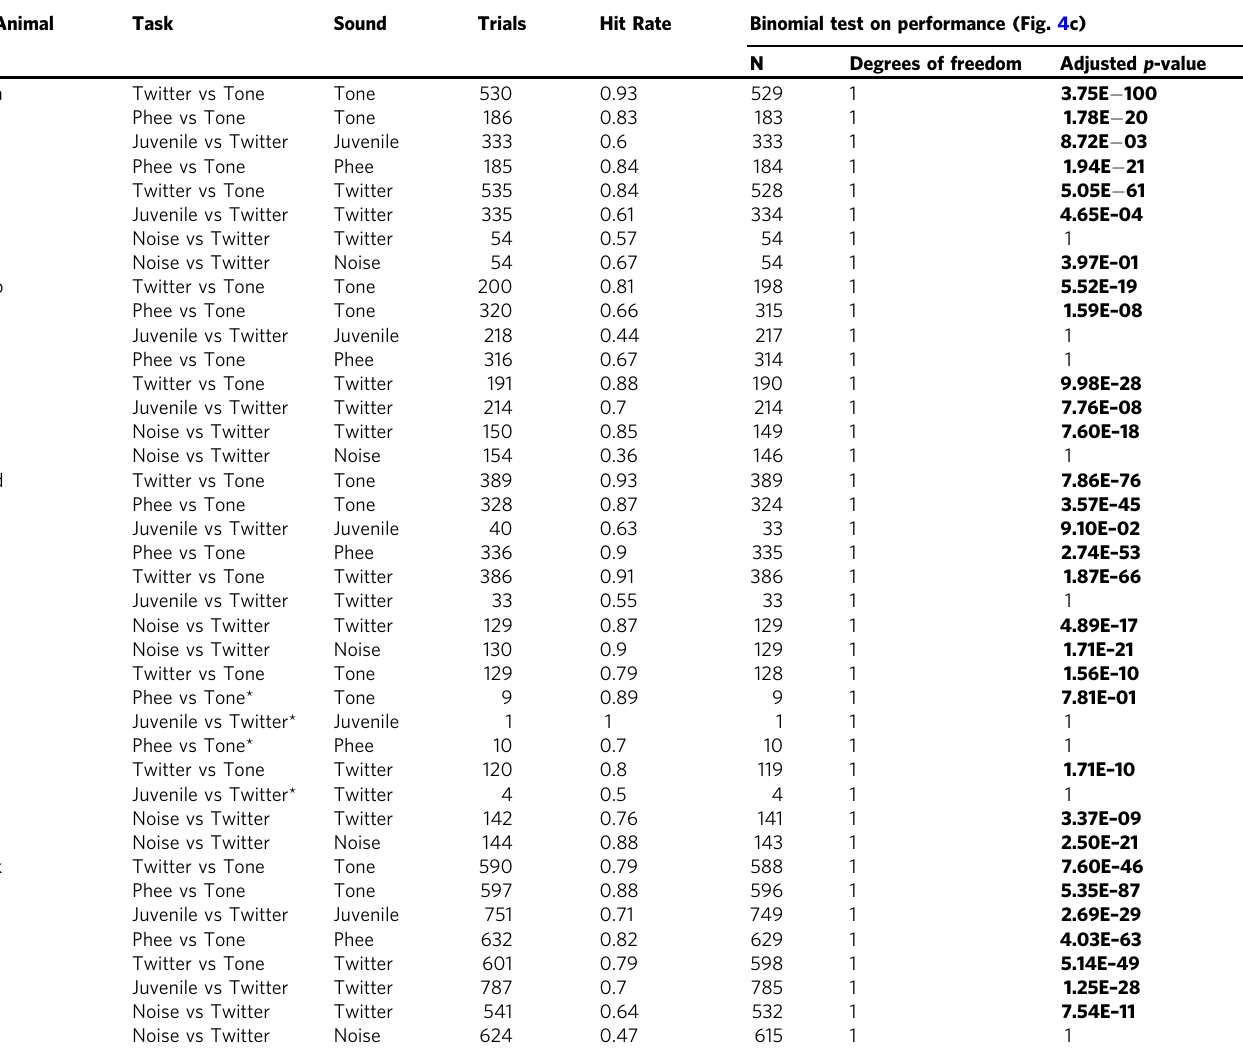
Table 3 Summary statistics for the Generalization to novel stimuli across animals and the four conditions (Fig.